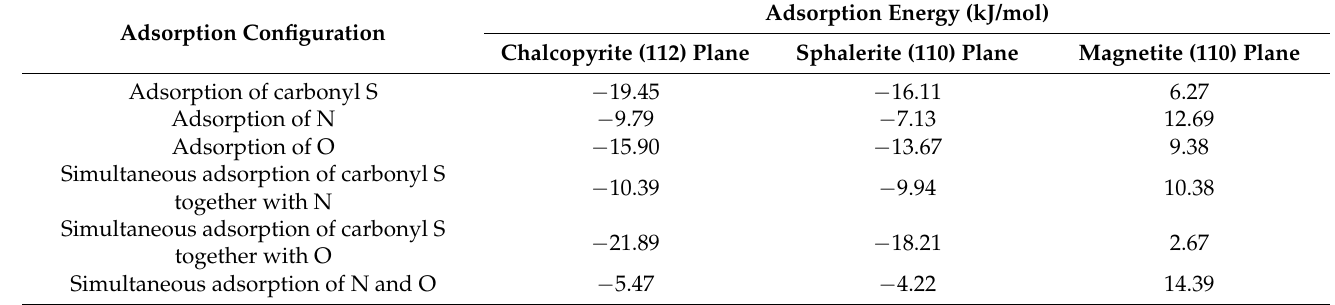
Table 10. Adsorption energies of adsorption configurations of Z-200 on different mineral crys- tal planes.